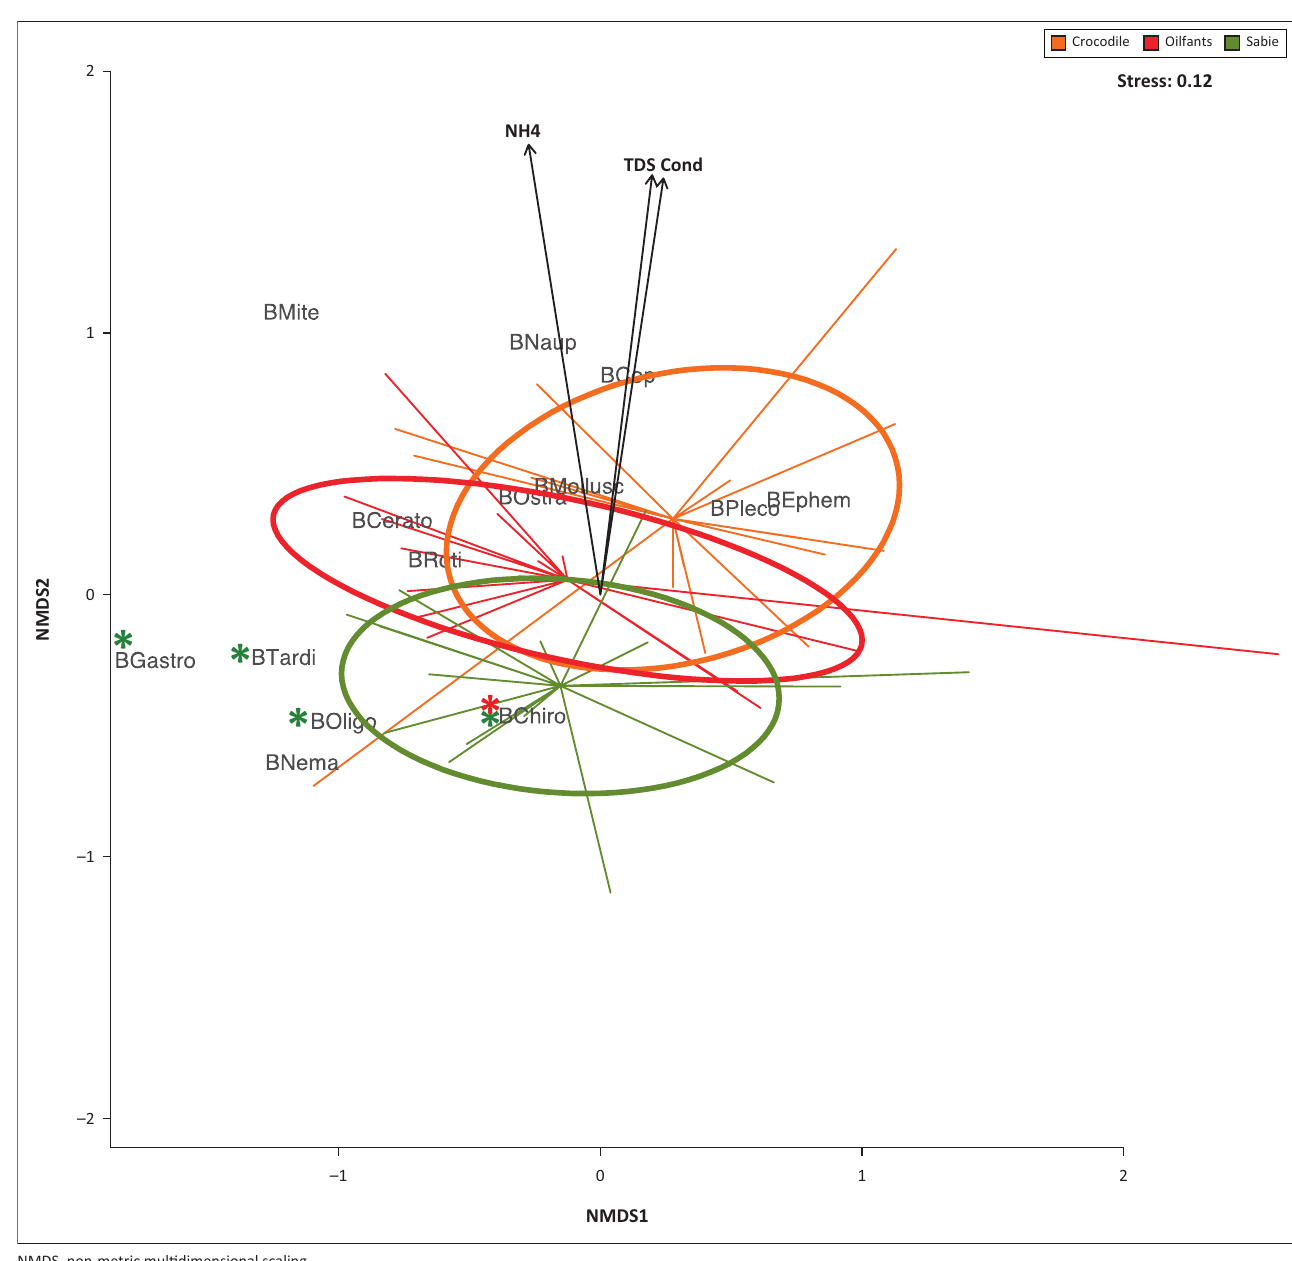
FIGURE 5: Non-metric multidimensional scaling ordination of the biofilm-dwelling meiobenthic community. Ordination is based on untransformed abundances (ind. cm –2